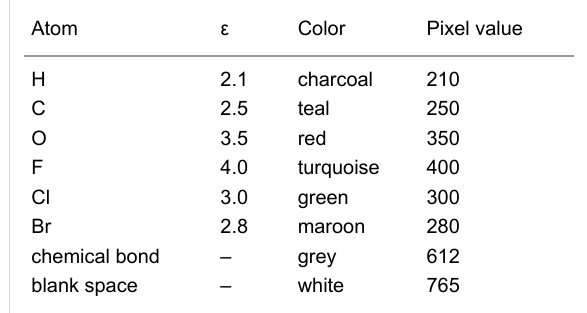
Table 5: Correspondence of Pauling's electronegativity with atomic colors and respective pixel values (as a combination of RGB compo- nents) used in the MIA-QSAR